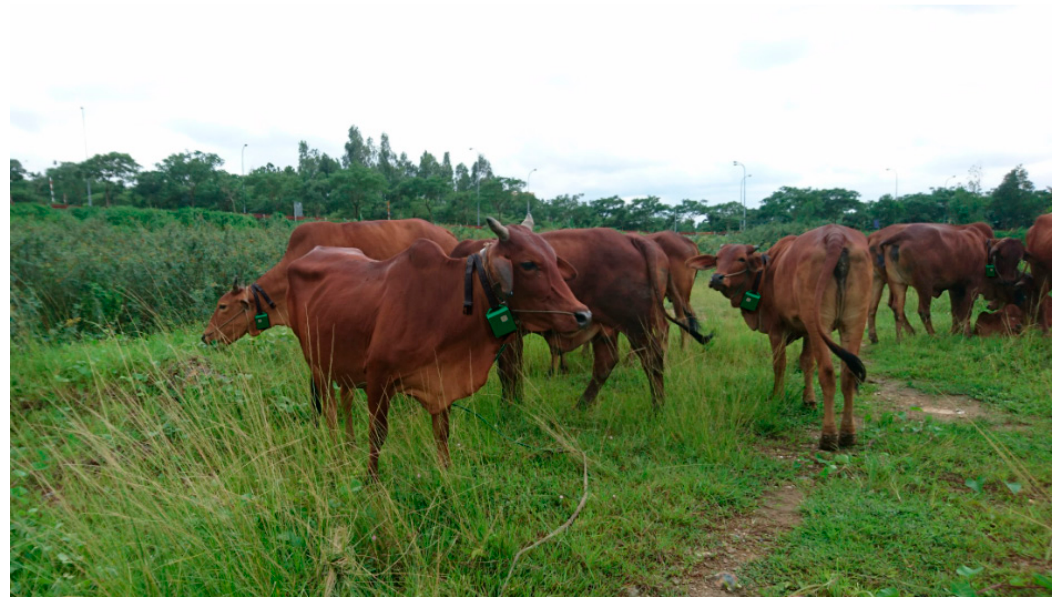
Figure 17. Example of a practical test for monitoring livestock during grazing.